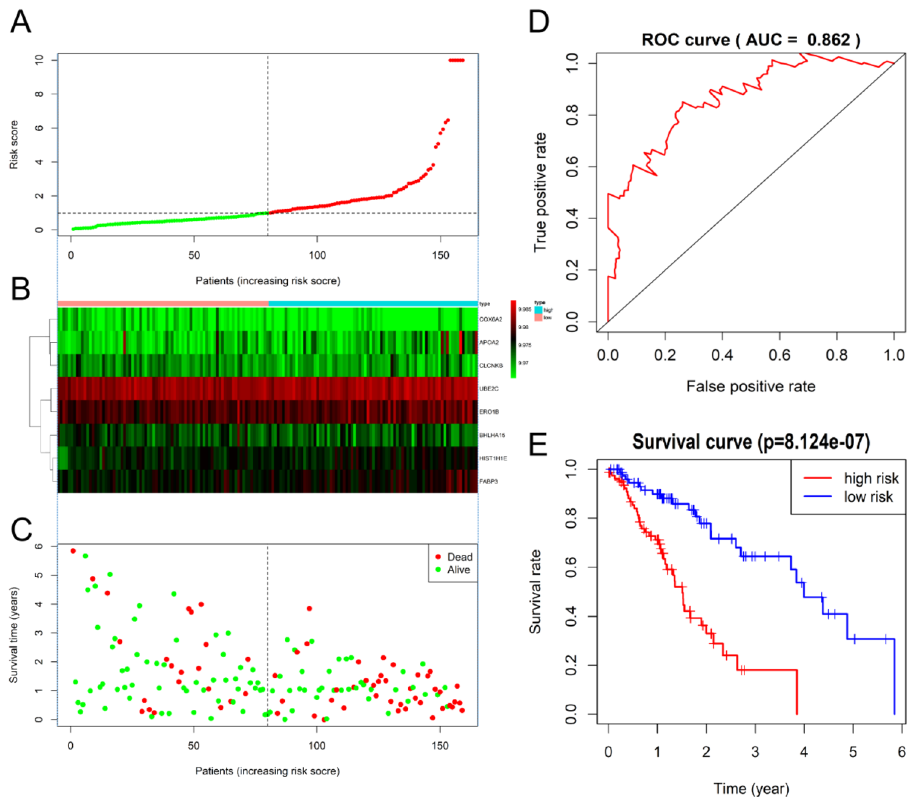
Figure 7. Performance evaluations of prognostic risk scoring model. ( A ) The patient’s risk score, red indicates high risk and green indicates low risk. ( B ) Expression heat map of eight genes in high-risk group and low-risk group (Blue represents the high-risk group and red represents the low-risk group). ( C ) Distribution of survival status of patients in high-risk group and low-risk group (red indicates death and green indicates survival). ( D ) ROC curve of comprehensive risk scores of eight genes. AUC (area under curve) indicates the area below the ROC curve. The value is between 0 and 1. The higher the value, the better the prediction effect of the model. ( E ) KM survival curve of patients with the EC with low or high comprehensive risk score of eight